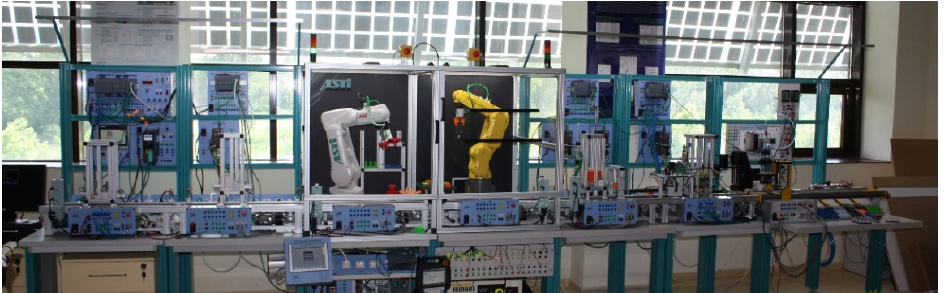
Figure 1. Flexible manufacturing system.